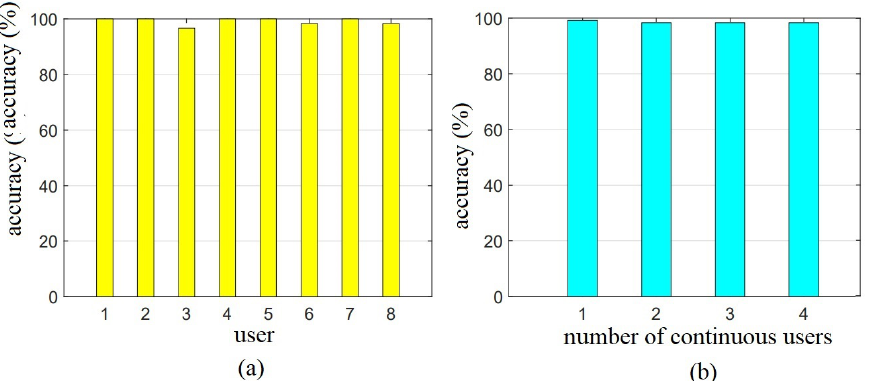
Figure 17. Detection accuracy for the visitors with different shapes and behaviors.